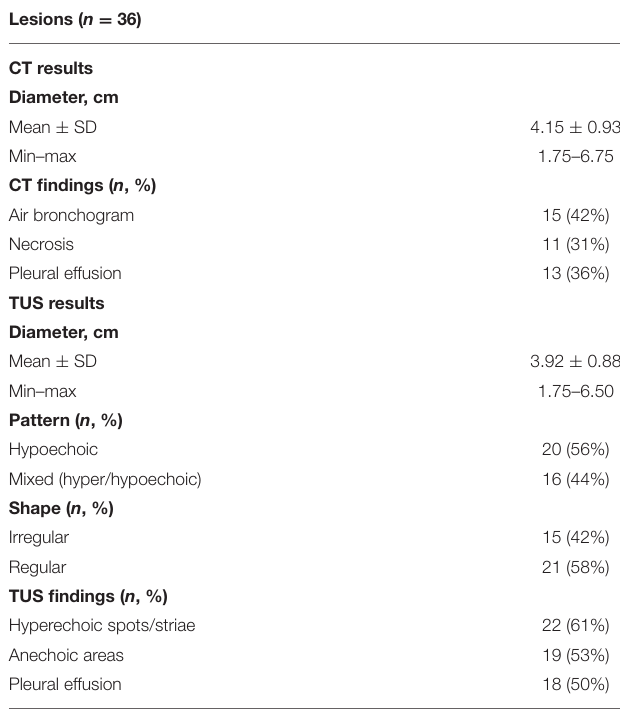
TABLE 1 | Characteristics of the biopsied lesions on CT scan and TUS